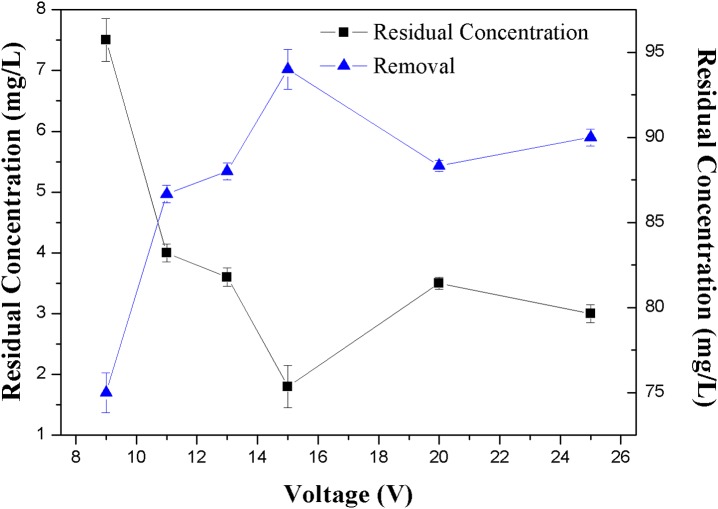
Effect of the voltage on the removal efficiency of NH3-N.